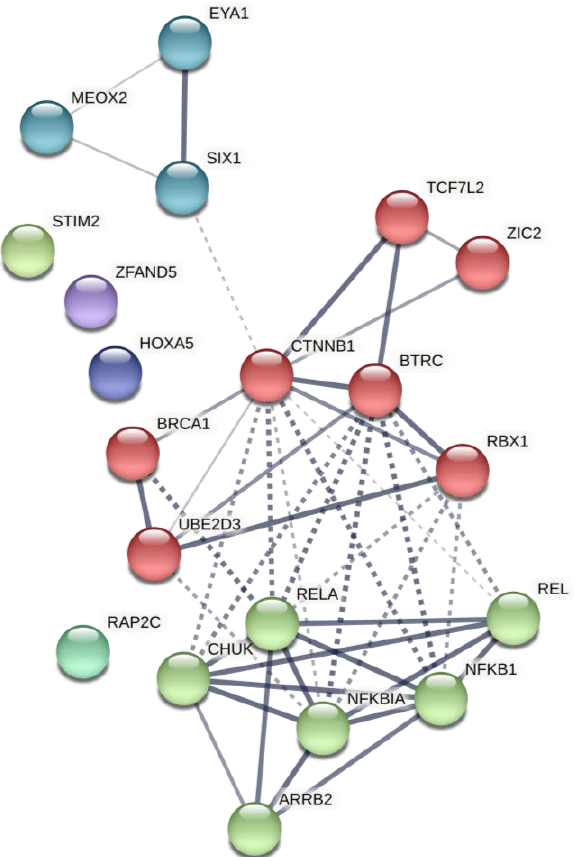
Figure 6. Network 3: Interaction network based on initial predicted miR-TF network. This network was reconstructed by ten genes with the highest degree involved in the predicted regulatory miR-TF networks. Each cluster is illustrated with a different color. Edges represent protein–protein associations. Chromatic edges indicate highest (0.9), high (0.7), medium (0.4), and low (0.15) confidence. Inter-cluster edges are shown with dashed lines. miR, microRNA; TF, transcription factor.